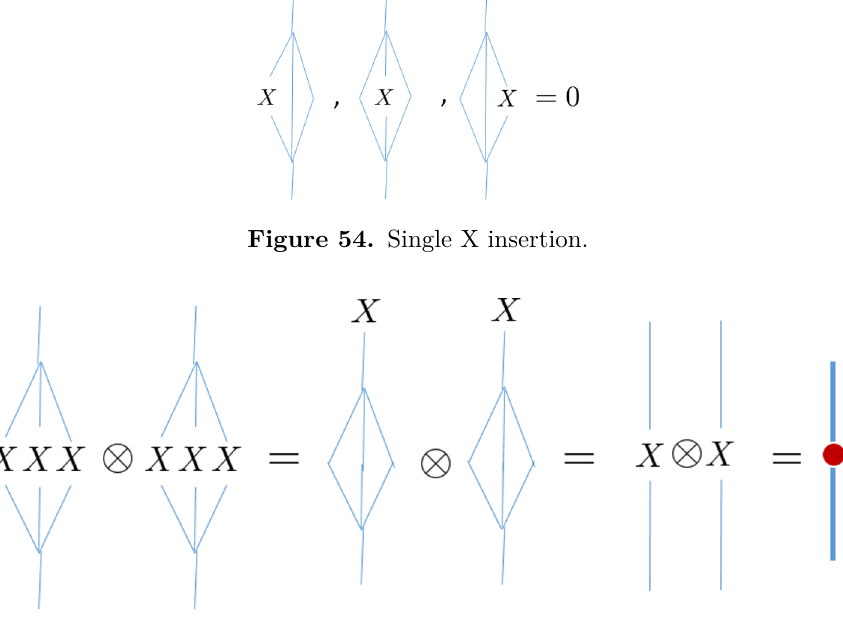
Figure 55. Inserting X ⊗ X on the same leg of the double copy code only yield non-zero terms as shown in the